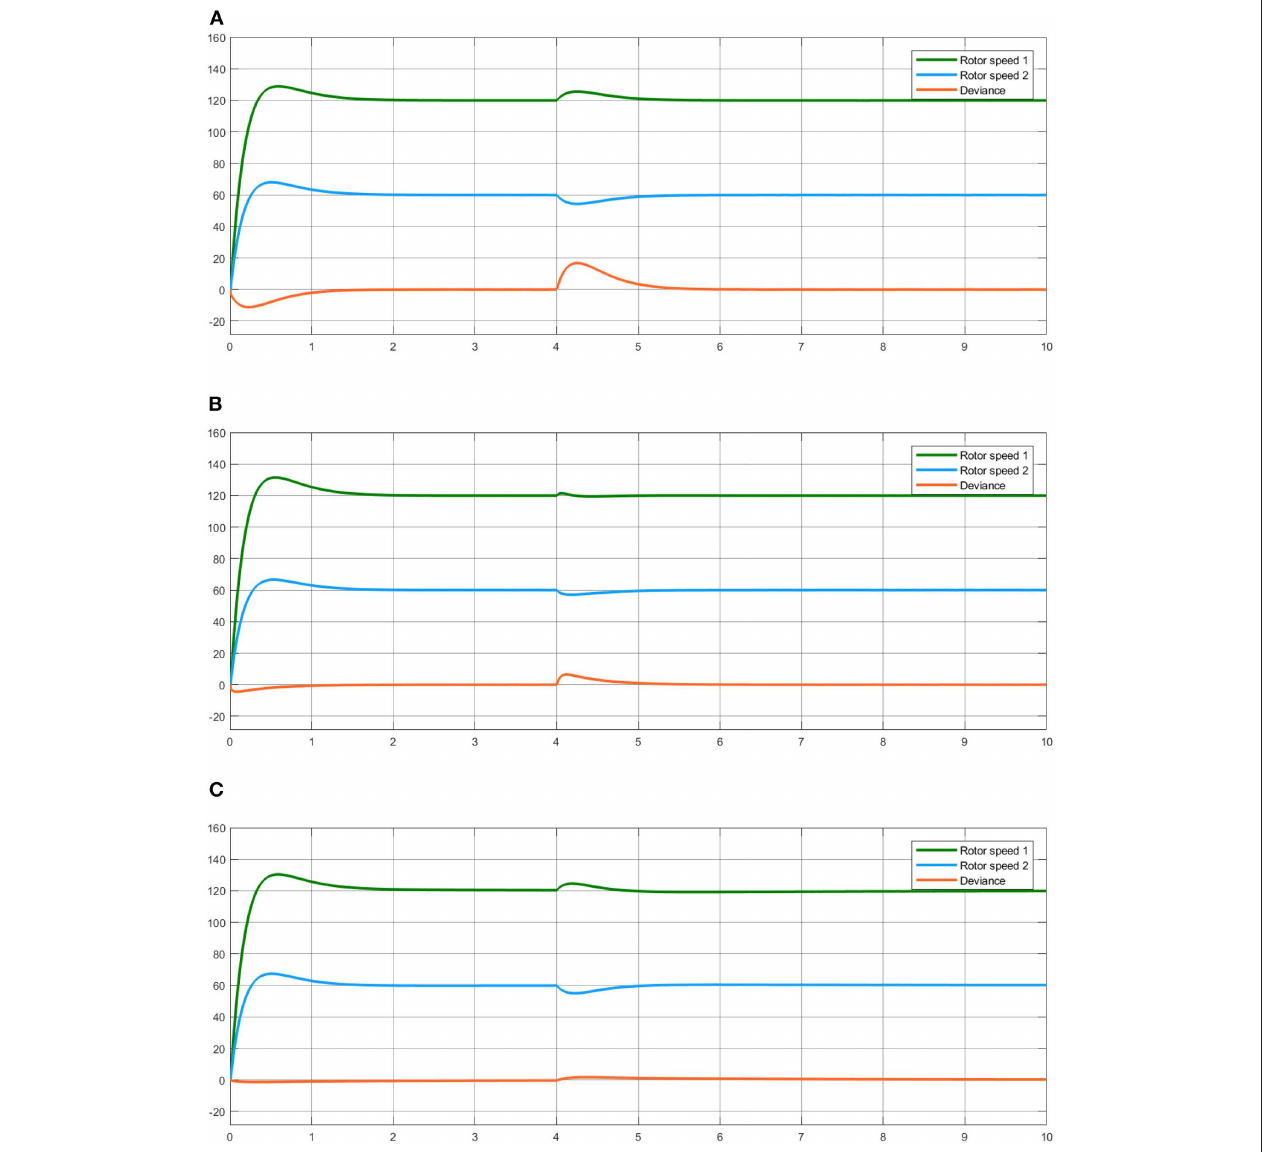
FIGURE 14 | Simulation results for when the load changes. (A) Control method without collaborative control. (B) Collaborative control method without PID controller. (C) Collaborative control method including PID controller.